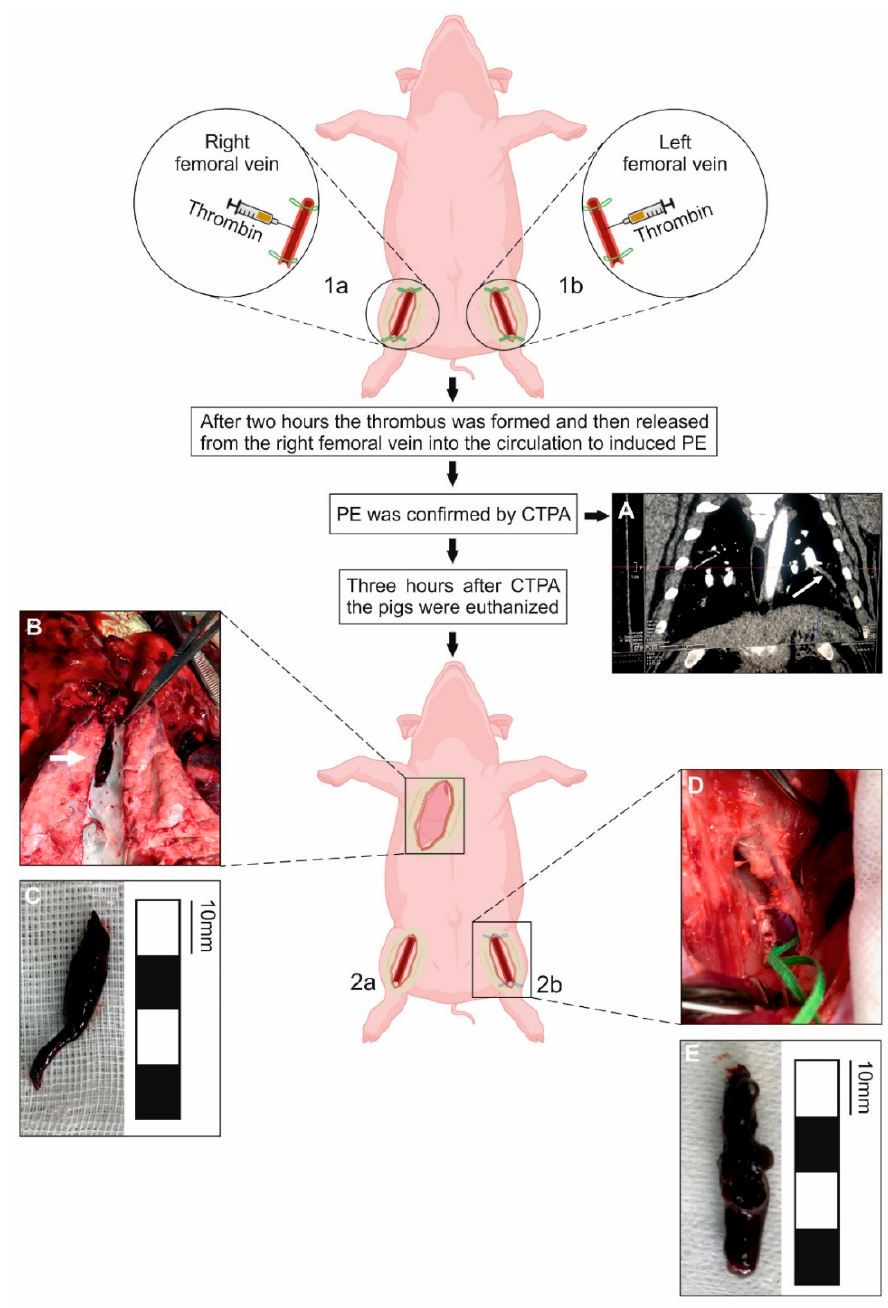
Figure 1. A porcine model of venous thromboembolism (VTE) based on the formation of the thrombus in vivo. The dia- gram represents the following stages of the porcine VTE model development. Both right (1a) and left (1b) femoral veins were closed proximally and distally at the length of about 30–40 mm with surgical ligatures. To accelerate the thrombus formation the thrombin was administered into the closed segment of each vein. Two hours later, the thrombus was re- leased from the right femoral vein (2a) to induce pulmonary embolism (PE). PE was confirmed via both CTPA (( A ) a representative CTPA scan; white arrow indicates the embolus in the pulmonary artery) and an autopsy (( B ) a representa- tive image of the embolus, indicated by a white arrow, in the left segmental pulmonary artery found at autopsy; ( C ) an embolus collected from the left segmental pulmonary artery). The left femoral vein with the remaining thrombus (2b) was gently exposed and cut open to remove the thrombus (( D ) the exposed left femoral vein with the remaining thrombus closed with the surgical ligatures; ( E ) an image of the thrombus removed from the left femoral vein).